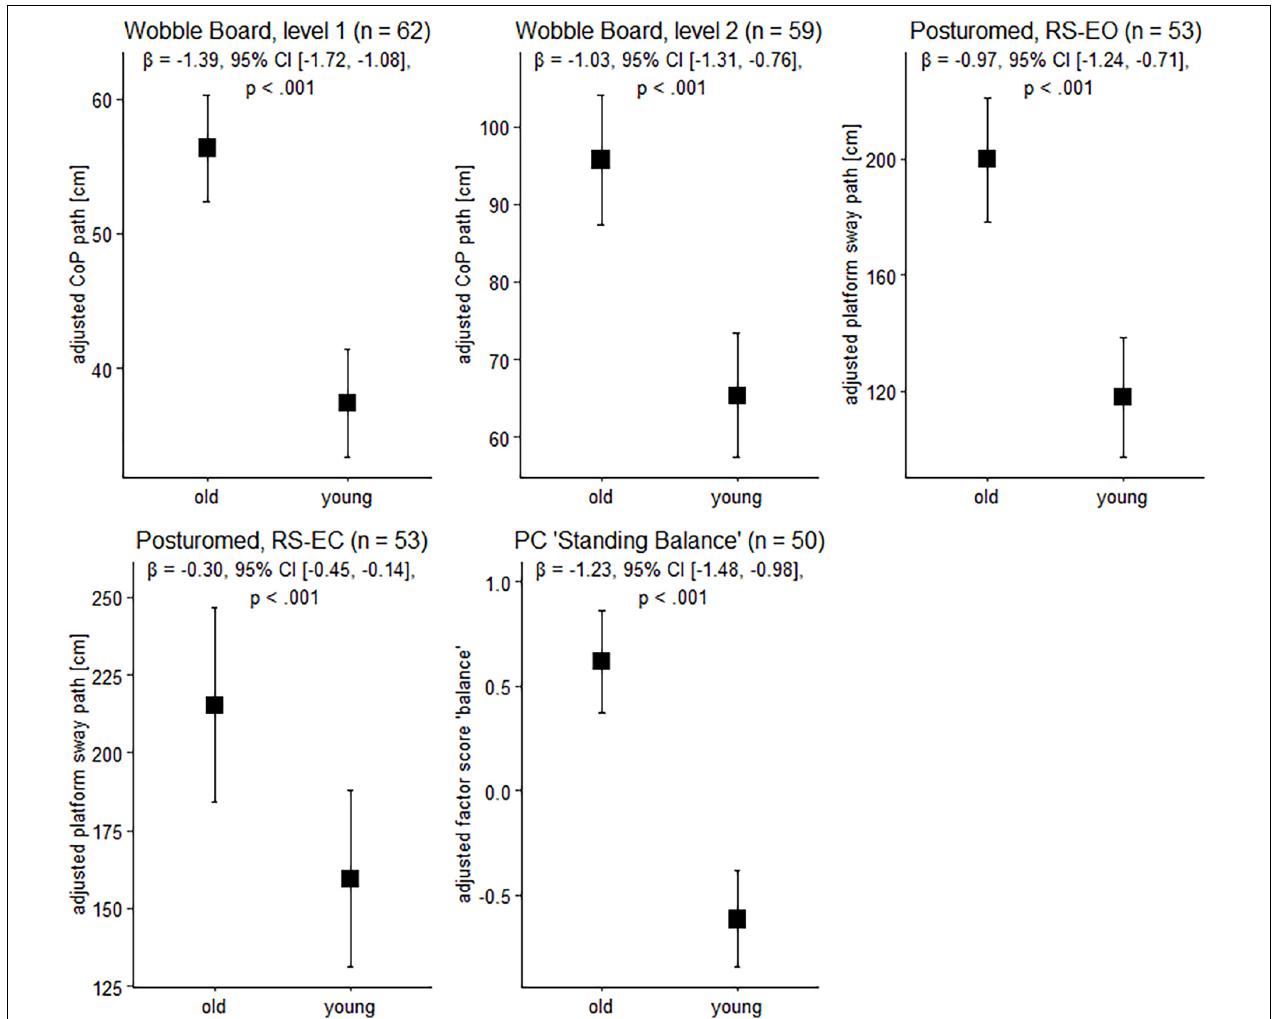
FIGURE 1 | Balance performance in older and younger participants. Data are presented as predicted group means (corrected for the influence of sex and Baecke’s sport score) and the corresponding 95% CI (error bars). Note that the beta-coefficients reflecting the between-group differences in units of standard deviation are conceptually similar to Cohen’s d . Rules of thumb for interpreting this effect size are 0.2 < | β | < 0.5 “small,” 0.5 < | β | < 0.8 “medium,” and | β | > 0.8 “large” effects, respectively (cf. Cohen,